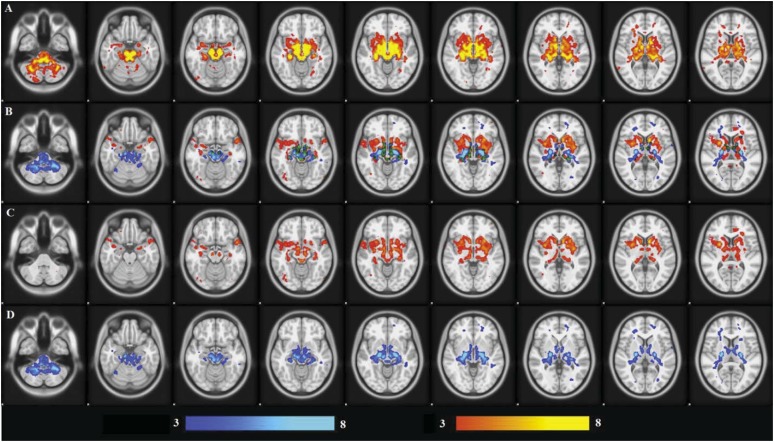
DOI:
http://dx.doi.org/10.7554/eLife.08440.024